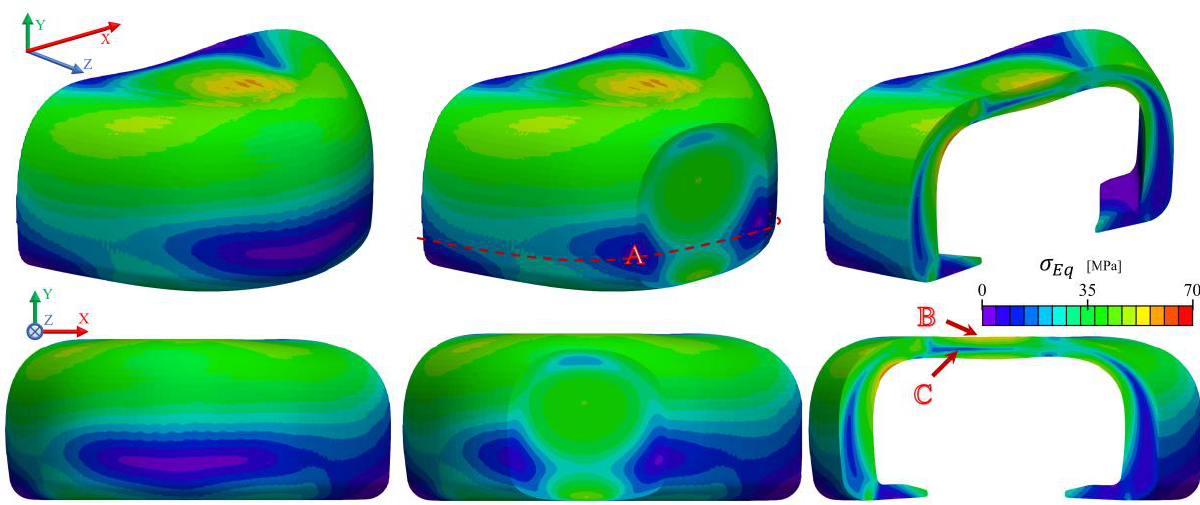
9 Figure 15. von Mises stress distribution in the compressive simulation computed with the M4 toe cap